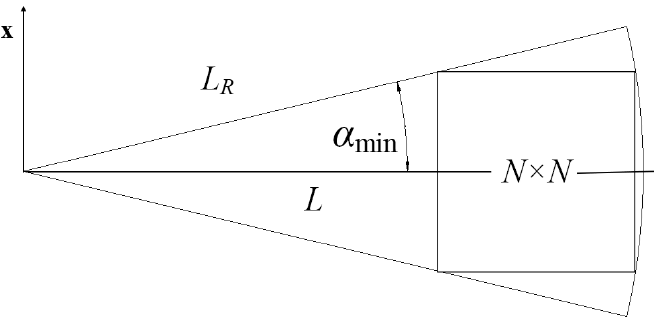
Figure 6. Sector searching area with a minimum central angle.